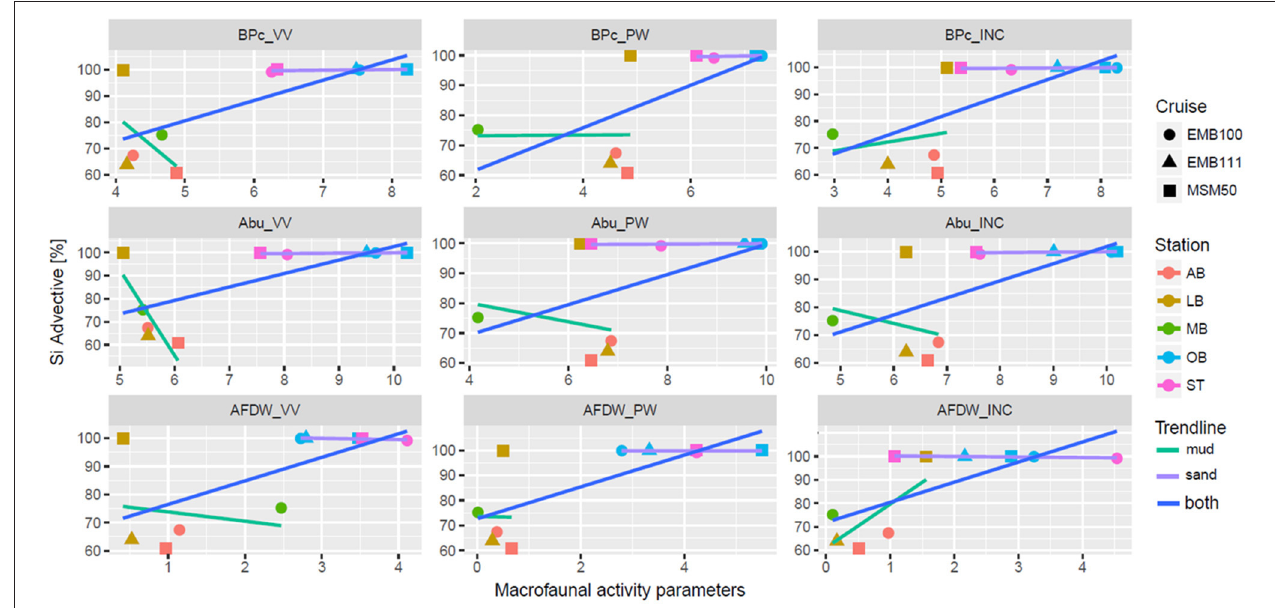
FIGURE 7 | Estimate of advective component (in %) of Si total fluxes at different sites and seasons (EMB100–spring 2015, EMB111–autumn 2015, MSM50–winter 2016) plotted against log-transformed major macrofaunal parameters (BPc_VV, BPc_PW, BPc_INC—community bioturbation potential estimated per m 2 based on Van Veen Grab (0.1 m 2 ) samples (VV), pore-water (PW) cores set and incubation (INC) cores set, respectively, Abu refers to respective abundance [ind/m 2 ] and AFDW—to biomass [AFDW g/m 2 ].